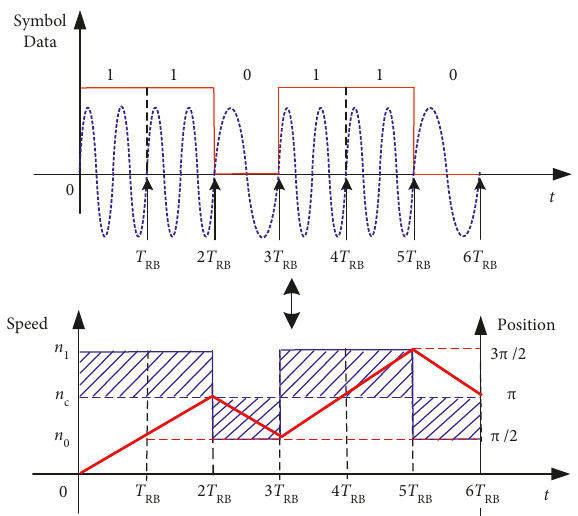
Figure 3: Rotating speed and rotor position control corresponding to the MSK